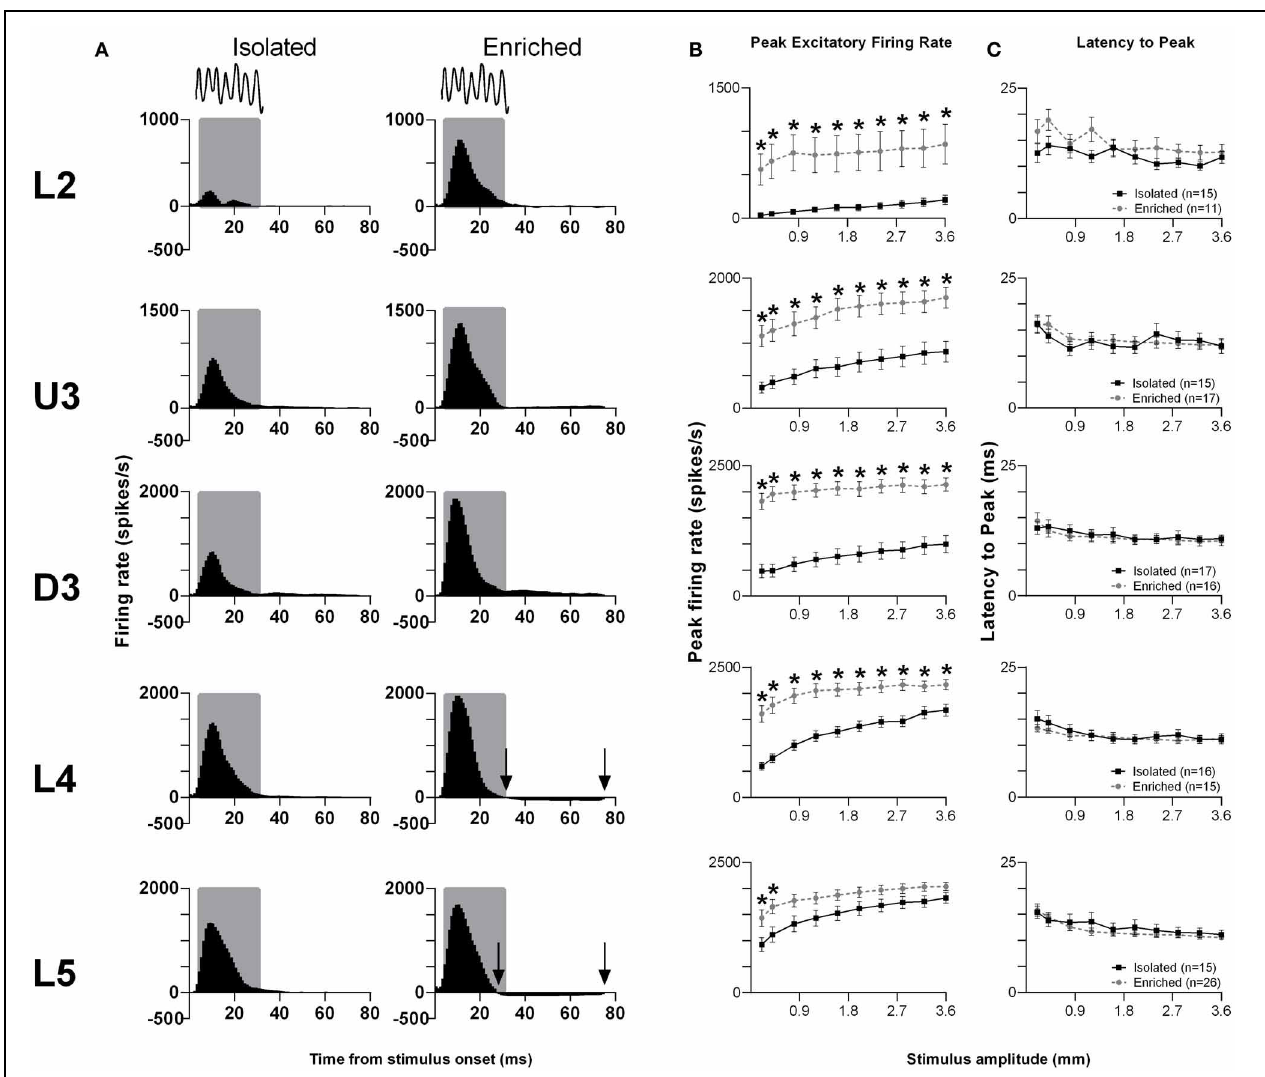
FIGURE 3 | EE effects on pattern, strength and timing of responses evoked by the smooth surface discrimination stimulus. Response strength significantly increased in all cortical laminae after EE, with no changes in response timing. (A) Population Grand PSTHs in response to the trapezoid with the fastest onset ramp velocity (400mm/s) in a specific lamina (indicated to left of panel) in EE and Isolated animals. Laminar designations: L2, Layer 2; U3, Upper Layer 3; D3, Deep Layer 3; L4, Layer 4; L5, Layer 5. Each Grand PSTH was generated by averaging responses across all responsive clusters in that lamina. The analysis window used to extract